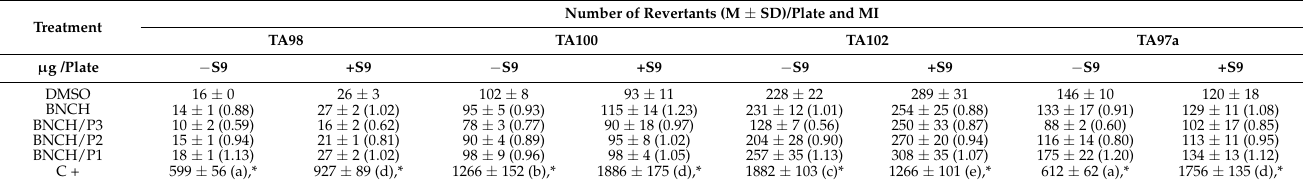
Table 3. Number of revertants/plate and MI from BNC formulations containing EPP-AF ® . Posi- tive control (C+): (a) 4-nitro-o-phenylenediamine (10.0 µ g/plate–TA98, TA97a); (b) sodium azide (1.25 µ g/plate–TA100); (c) mitomycin C (0.5 µ g/placa–TA102) in the absence of S9 and (d)